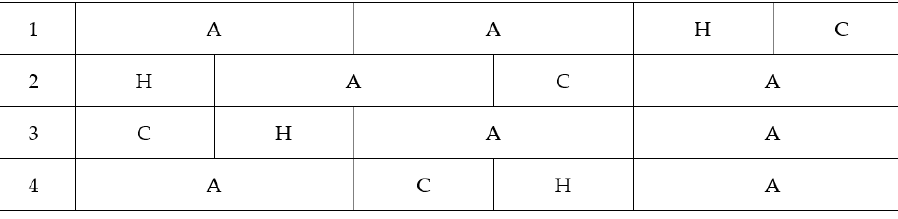
Figure 2. Four parallel beds ’ interconnection sequence (A: adsorption, C: cooling, H: heating).